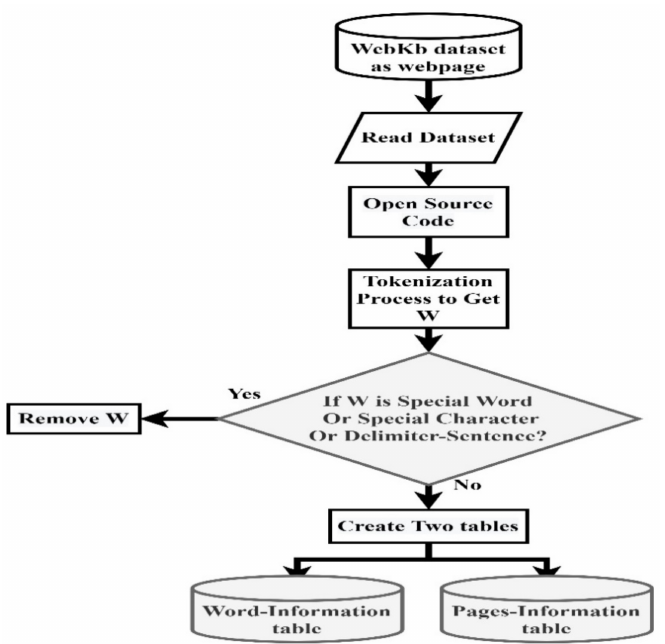
Figure 4. General flowchart of advanced document indexing method